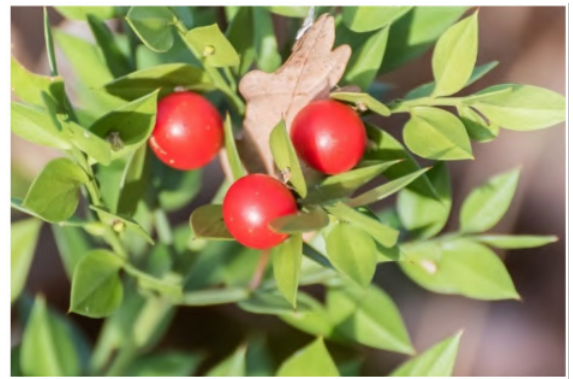
Figure 3. Ruscus aculeatus L.